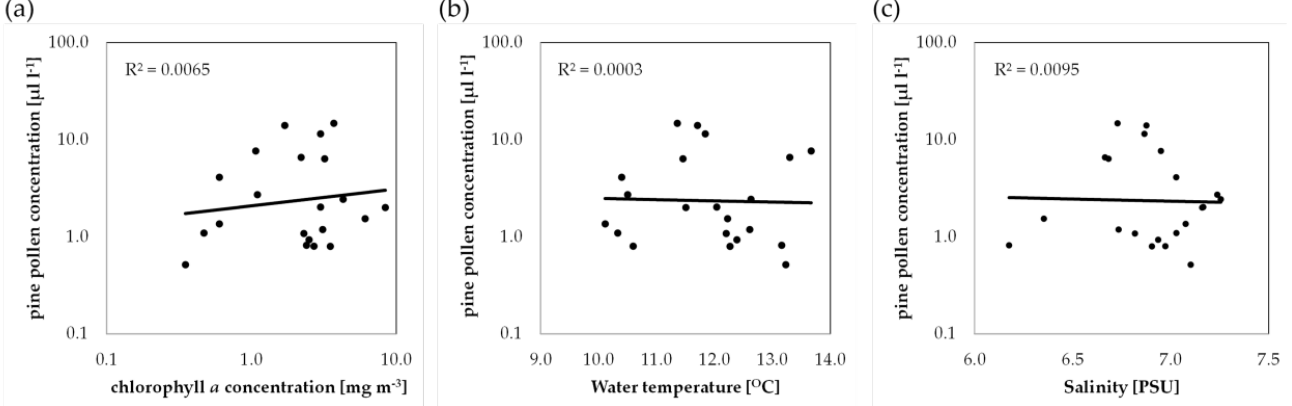
Figure 4. Relationships between pine pollen concentration measured by LISST-100X and ( a ) chloro- phyll a concentration; ( b ) water temperature; ( c ) salinity.